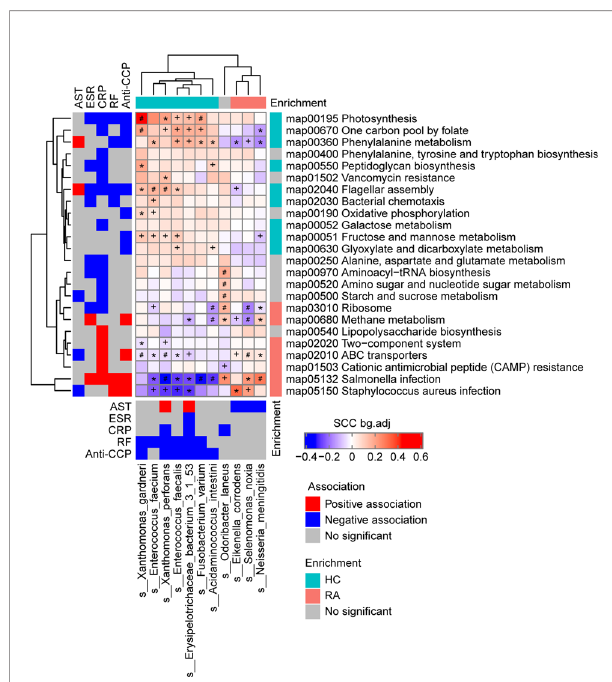
FIGURE 2 | Associations among the phenotypes (rheumatoid arthritis RA- related clinical indices), gut microbiome species, and gut microbiome functions (KEGG pathways) in the RA patients and healthy controls (HCs) at baseline. Left and bottom panels show signi fi cant correlations between the RA-related clinical indices and KEGG pathways or bacterial species, respectively (blue, negative association; red, positive association; grey, no signi fi cant association). Top and right panels show the treatment group- speci fi c enrichment of bacterial species and KEGG pathways, respectively (blue, HC-enriched; red, RA-enriched; grey, no signi fi cant difference). Middle panel shows the signi fi cant associations between the clinical index-related bacterial species and clinical index-related KEGG pathways (blue, negative; red, positive). +, FDR < 0.05; *, FDR < 0.01; #, FDR < 0.001, according to the Wilcoxon rank-sum test. AST, aspartate transaminase; ESR, erythrocyte sedimentation rate; CRP, high-sensitivity C-reactive protein; RF, rheumatoid factor;Anti-CCP, anti-cyclic citrullinated